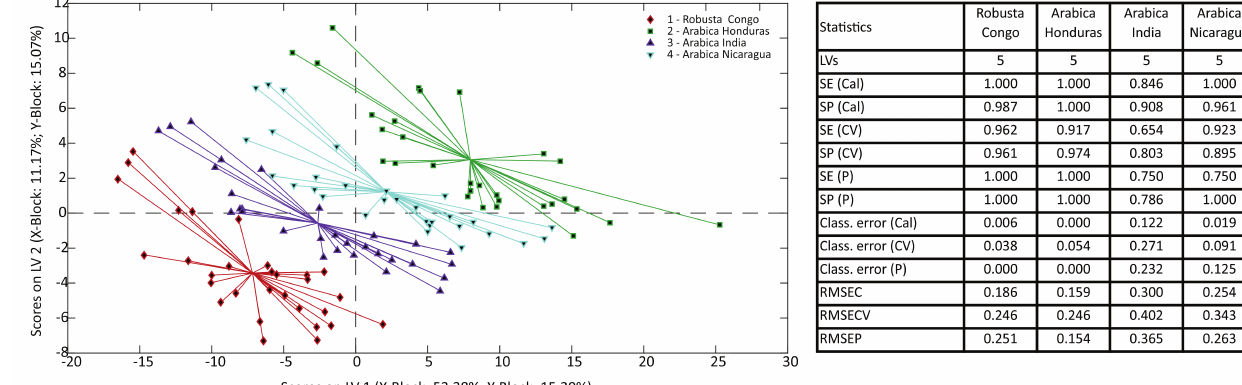
m/z.Table Fig. 3 - Score plot from a PCA applied to a BSPC, showing the dynamic over the 10 days of surveys evidenced by the VOCs complex (54 protonated ion signals tentatively identified) related to 120 Coffee samples. Outlier sam- ples were highlighted by a red Fig. 2 - Score plot of PLS-DA model and summary statistics for the 4 Coffee stocks samples based on 129 protonated